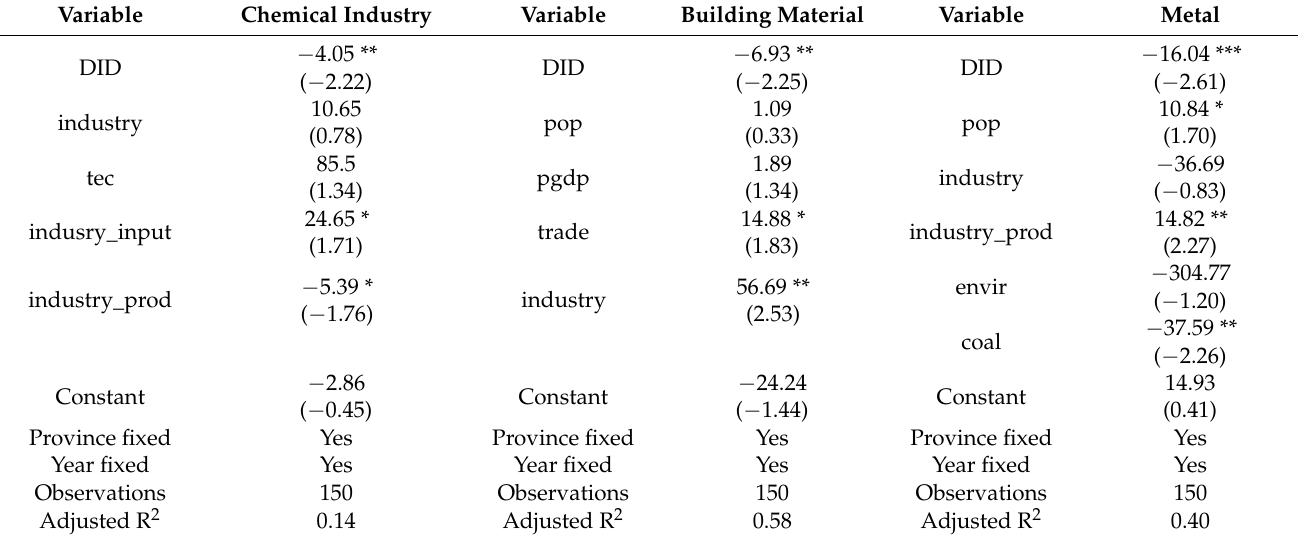
Table 2. Evaluation of production-based mitigation effects of carbon trading policy.